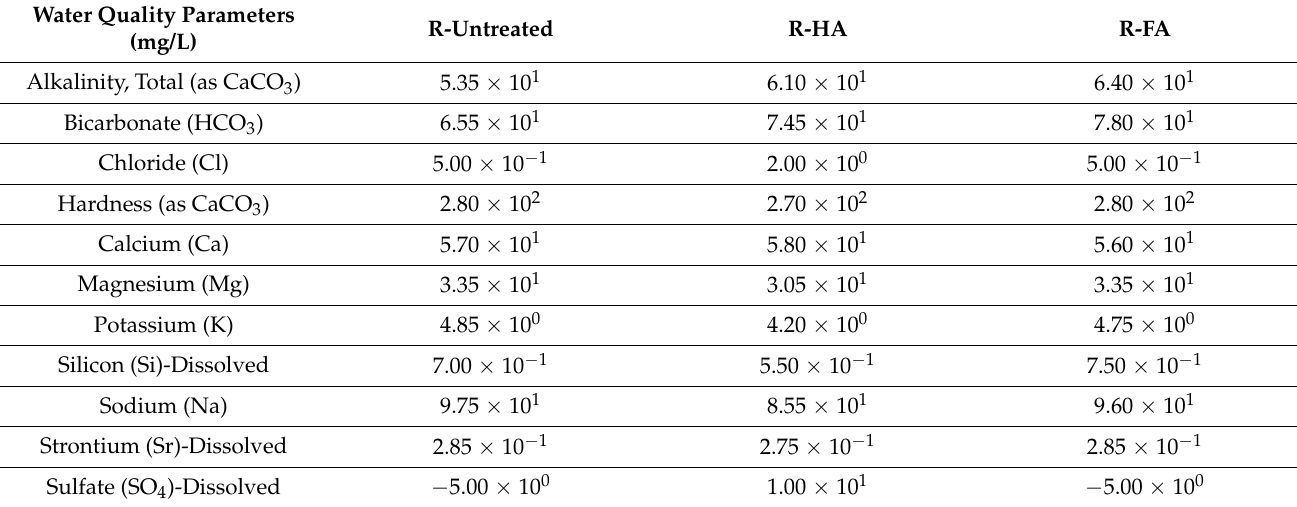
Table 9. Change in concentration of water quality parameters (relative to initial raw water quality) from laboratory experiment versus control water sample (i.e., no pyrolusite media). R-untreated is the difference in concentration between raw water and average of all water samples with non-pretreated media; R-HA and R-FA are the same with media pretreated with HA or FA,